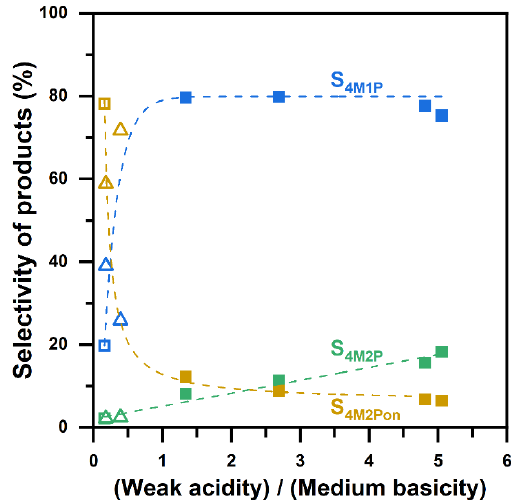
Figure 8. Correlation of product selectivity (S 4M1P , S 4M2P , and S 4M2Pon ) with the surface density ratio of weak acidity to medium basicity for x YSZ (filled squares), x Y/ t -ZrO 2 (open triangles), and bare t -ZrO 2 (open squares).